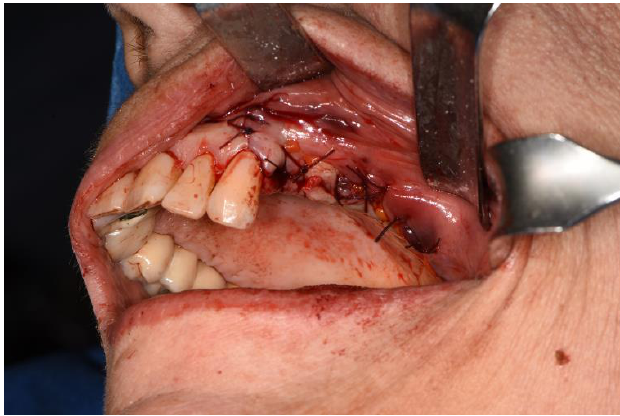
Figure 9. Buccal fad pad fixation.